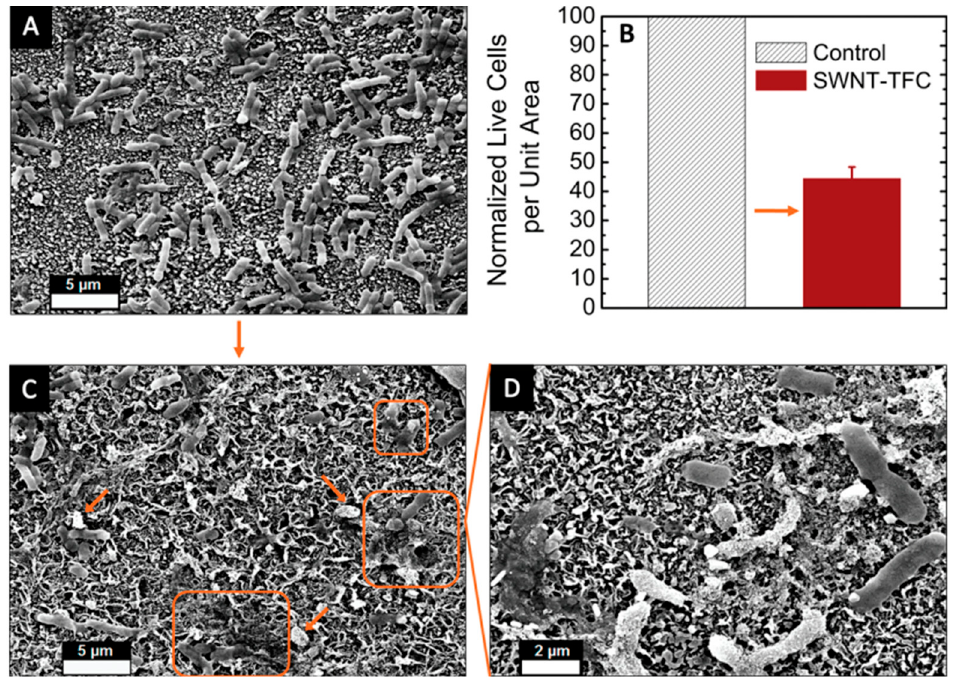
Figure 4. SEM micrographs displaying E. coli at the surface ( A ) control membrane and ( C ) an SWCNT-functionalized membrane at the end of the cytotoxicity test (some cells with lost integrity are highlighted in orange). ( D ) Magnified view of the surface of SWCNT-TFC membrane with E. coli cells [45]. ( B ) Colony-forming units (area units are in μ m²) enumerated from E. coli bacteria resuspended from functionalized SWCNT-TFC membranes (red) normalized with those of control membranes (shaded). The tests involved incubation of bacterial suspension in contact with the membrane surface for 1 h in 0.9% NaCl at room temperature (23 °C). Bars with standard deviation represent the average of three separately cast and reacted membranes (Reproduced with permission from ACS Publications; adapted from Tiraferri et al, 2011 [48]).